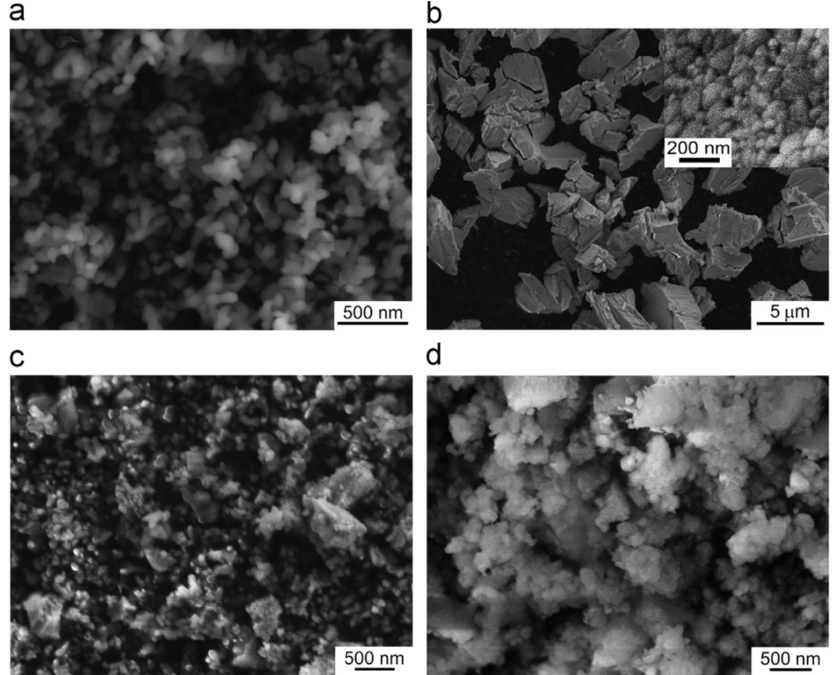
Figure 3. SEM images of Al 2 O 3 ( a ), Y 2 O 3 ( b ) starting nano powders, as well as 2.88 Y 2 O 3 –0.12Nd 2 O 3 –5Al 2 O 3 powder mixture ( c ) and Y 2 O 3 powders after planetary ball milling for 15 h ( d ) [16]. Reprinted with permission from Ref. [16]. Copyright 2014, copyright ELSEVIER.